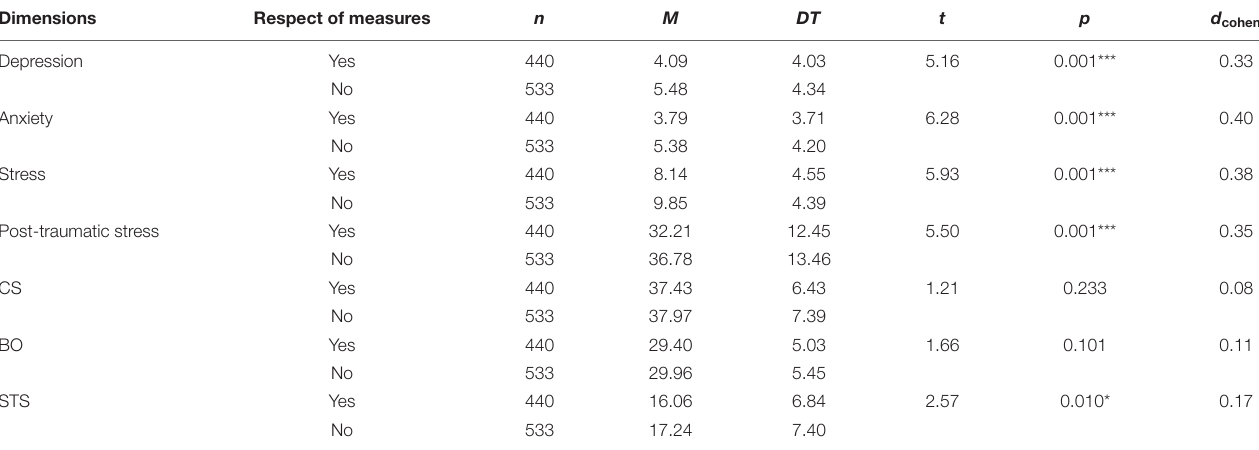
TABLE 7 | Results of univariate analysis of variance for different symptoms according to the perception of whether society is respecting health measures. Dimensions Respect of measures n M DT t p d cohen Depression Yes